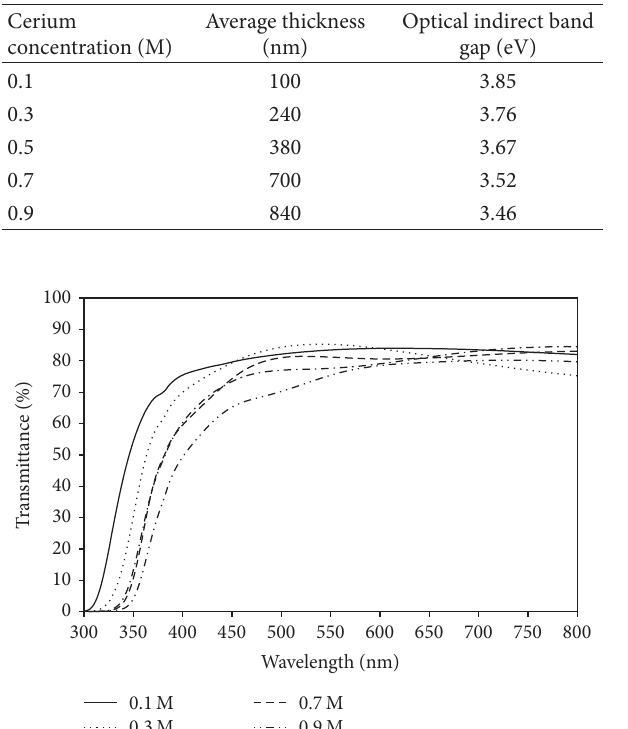
T 1: icknesses and optical indirect band gaps of the different